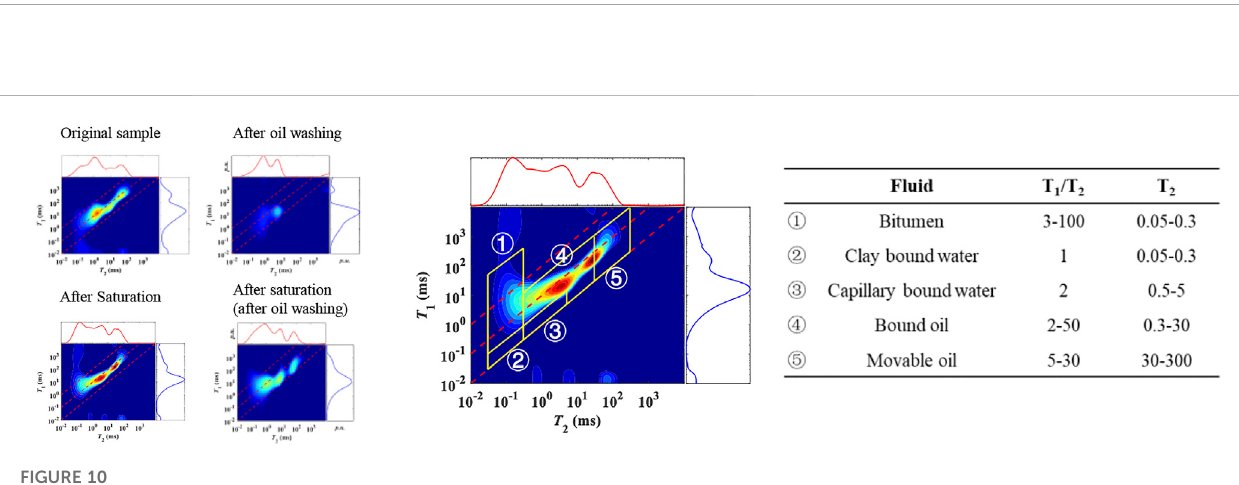
FIGURE 10 Sand shale.